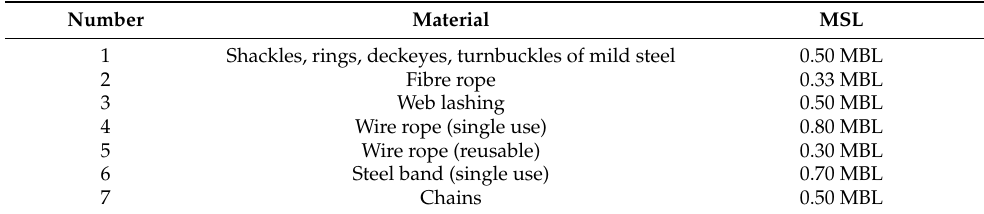
Table 1. Determination of MSL from breaking strength.